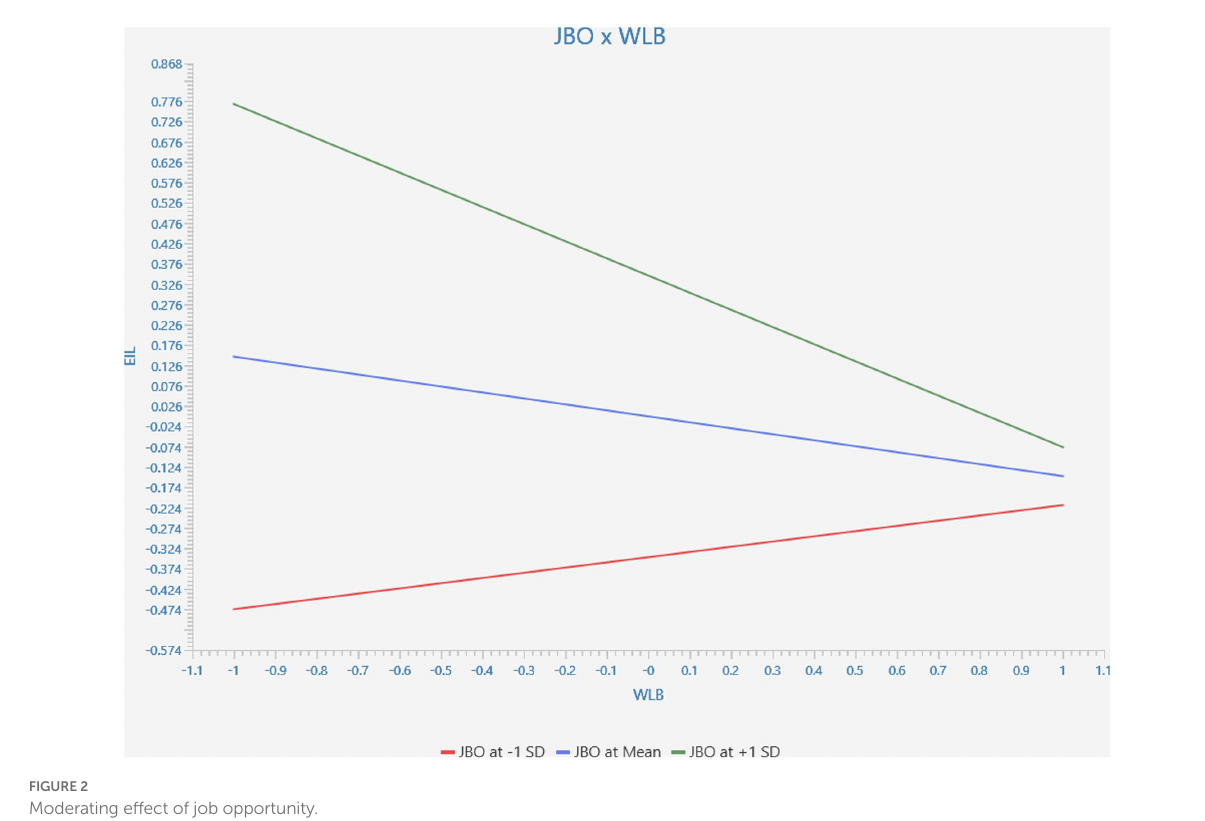
FIGURE 2 Moderating effect of job